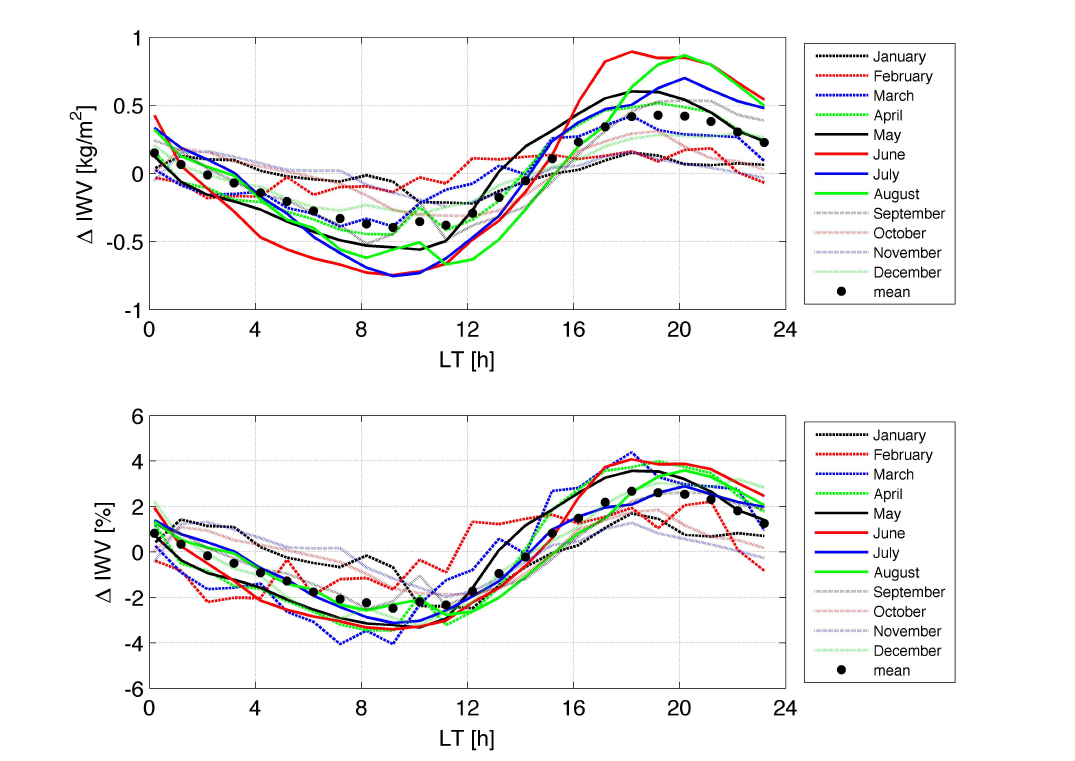
Figure 5. Seasonal dependence of the diurnal cycle in ∆ IWV as a function of local time over Bern for the time interval 2004–2016. The upper panel shows the absolute diurnal cycle ( ∆ IWV = IWV − monthly mean of IWV) while the lower panel shows the relative diurnal cycle with respect to the monthly mean and in percent. The black dots indicate the annual mean of the seasonal